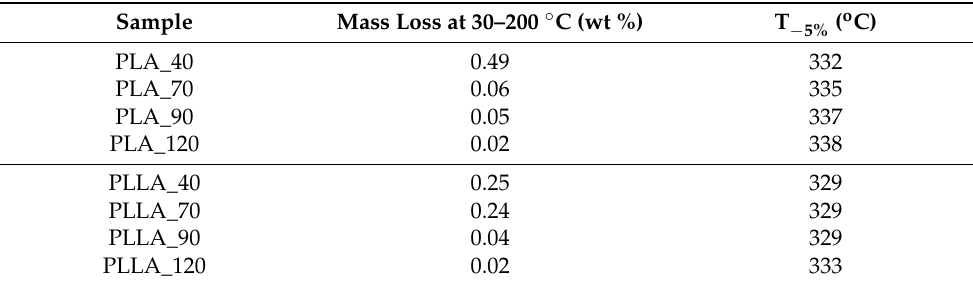
Table 2. Mass loss at 200 °C and the temperature corresponding to a 5 wt % mass loss of PLA and PLLA microspheres.